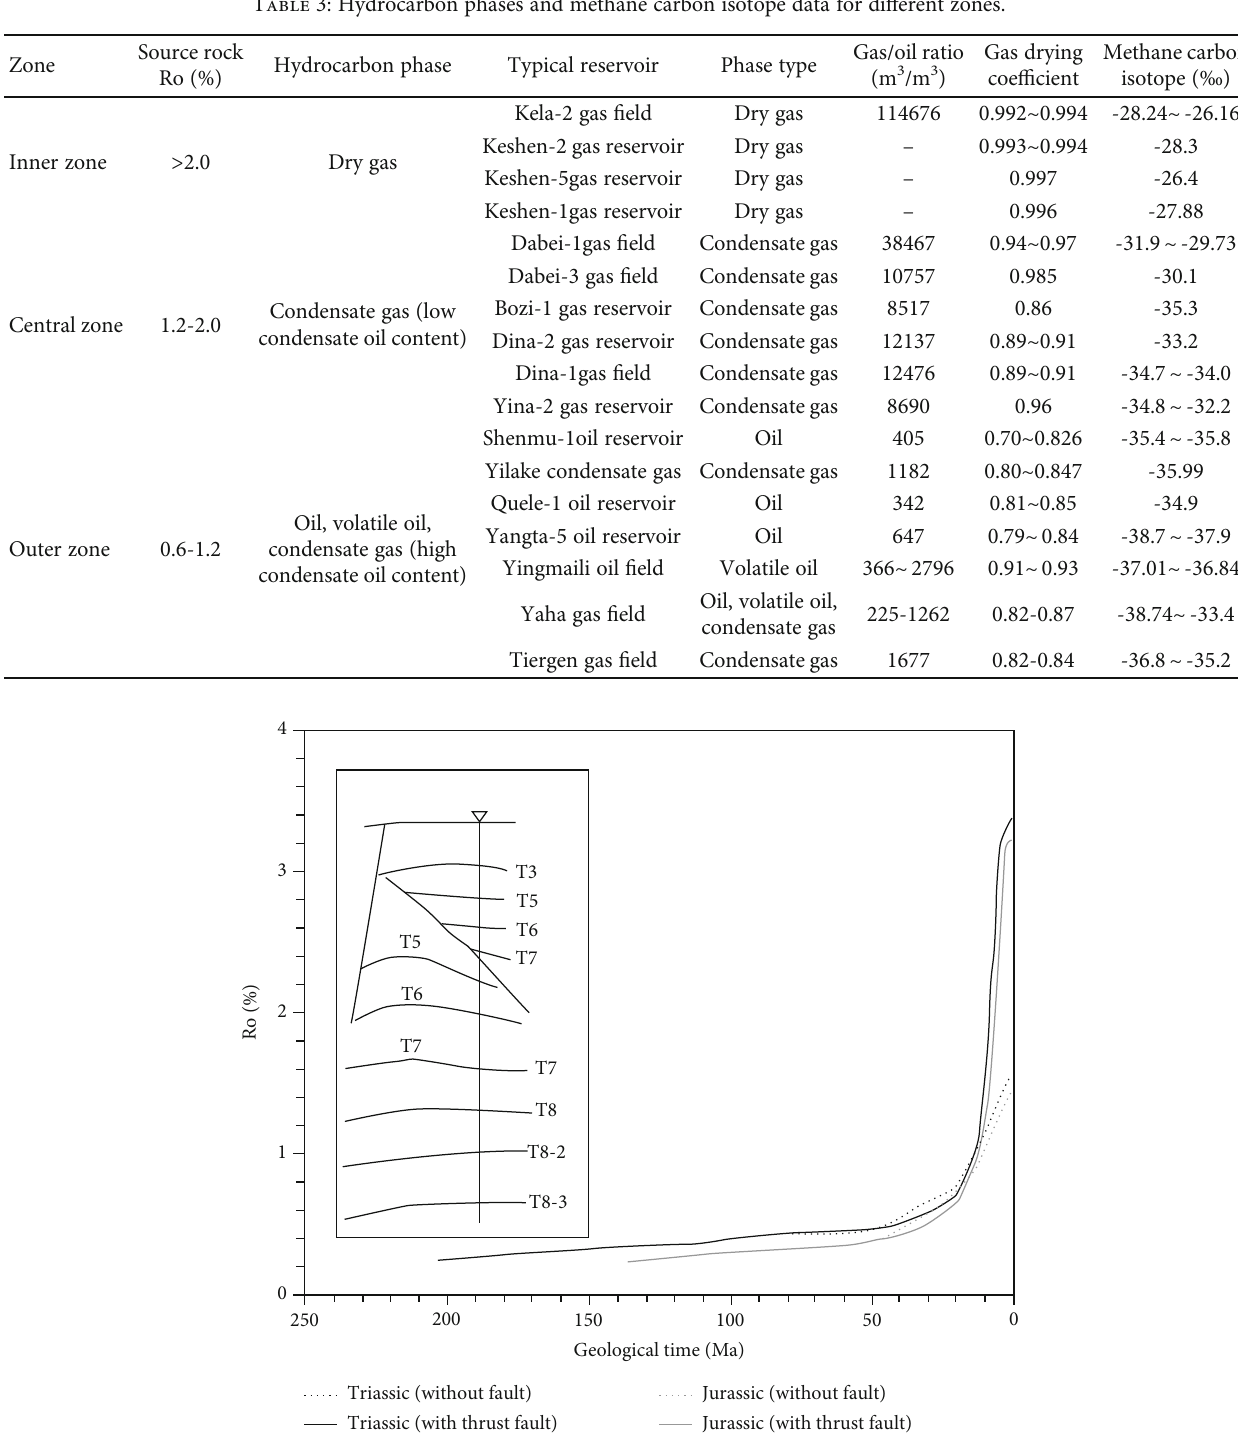
Figure 10: The e ff ect of the thrust fault on the source rock maturity illustrated by a virtual well